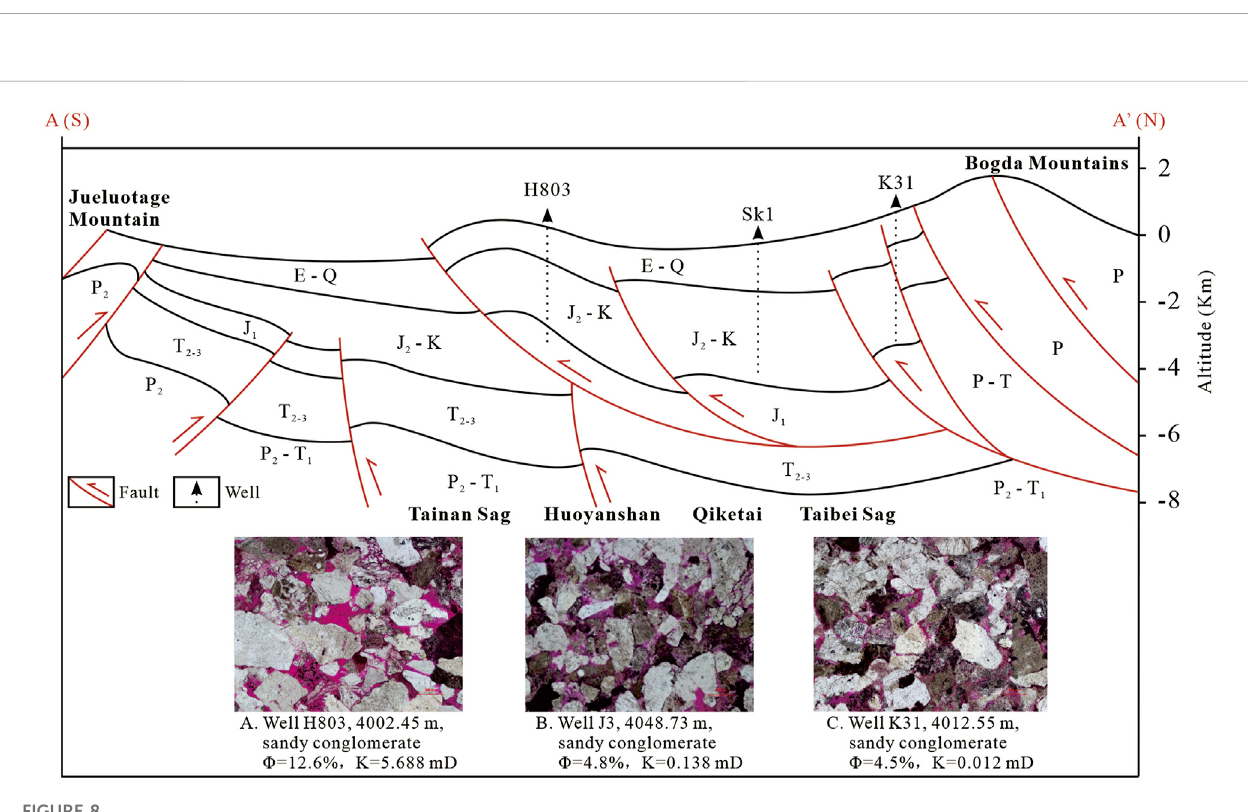
gradually from the beginning to the end with a “ plateau-trend ” stage at the early period of mercury injection compared with NLP samples (Figures 5A, C), indicating that the pore-throat sorting of AHP and NHP sandstones is better than that of NLP sandstones. The maximum